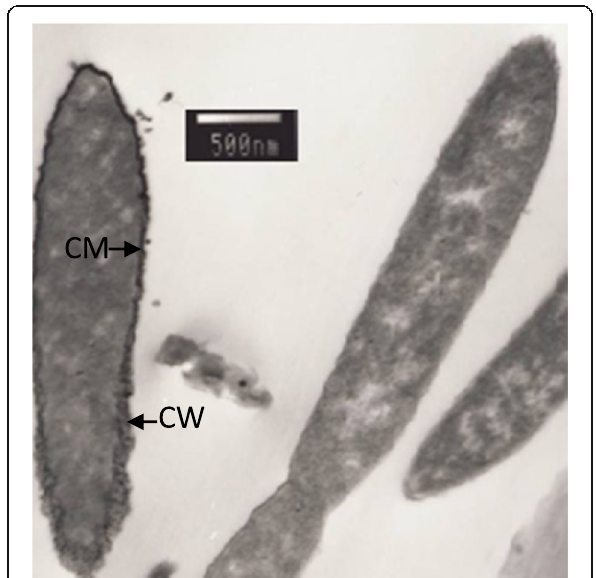
Fig. 1 Electron micrograph of negatively stained cells of strain USBA 82 T . An ultra-thin section revealing the presence of a typical Gram-negative cell wall ultra-structure CW: cell wall; CM, cytoplasmic membrane (Bar = 500